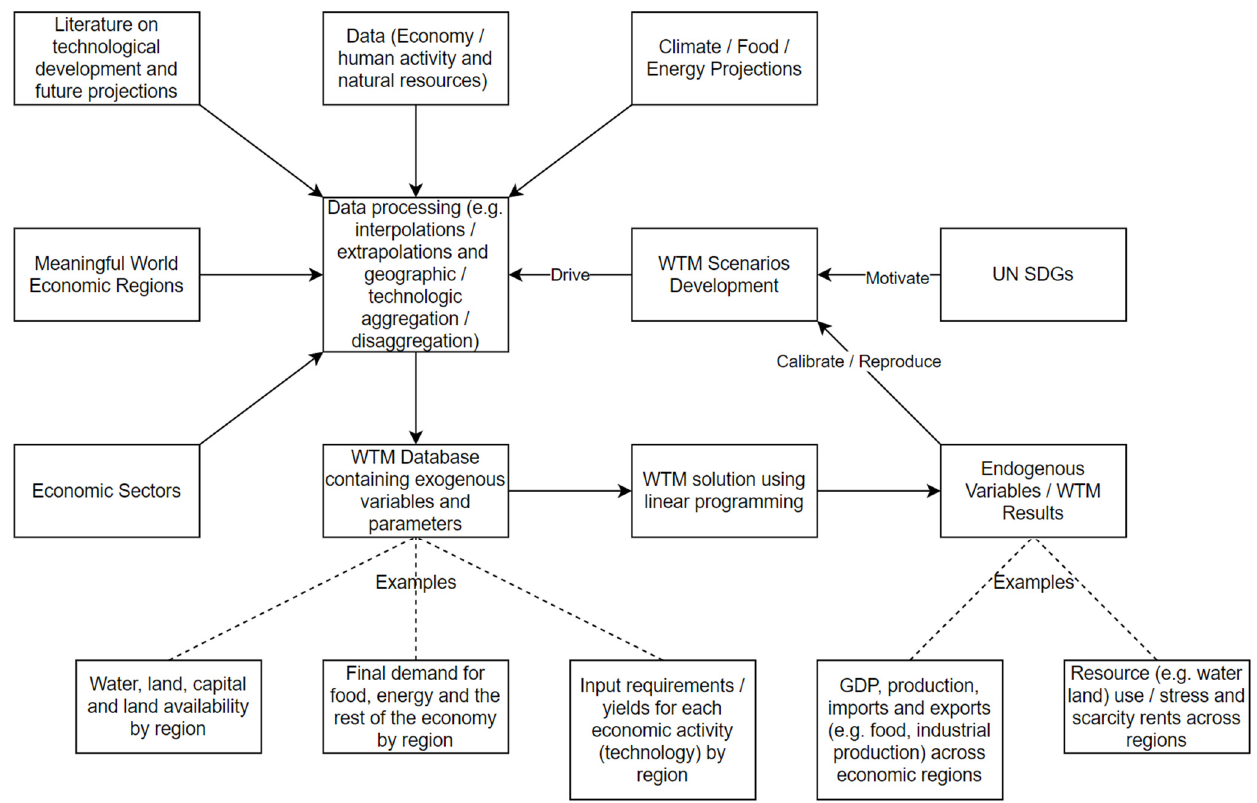
Figure 1. Model abstracting the workflow of this article. Source: own